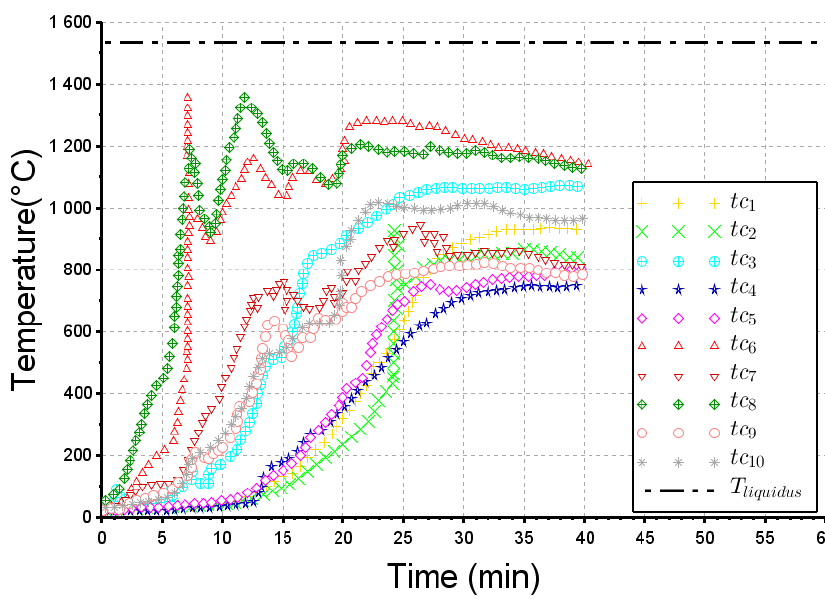
Figure 11. Actual thermograms from thermocouples 𝑡c 1 to 𝑡c 10 . 𝑇 𝑙𝑖𝑞𝑢𝑖𝑑𝑢𝑠 = 1536 °C